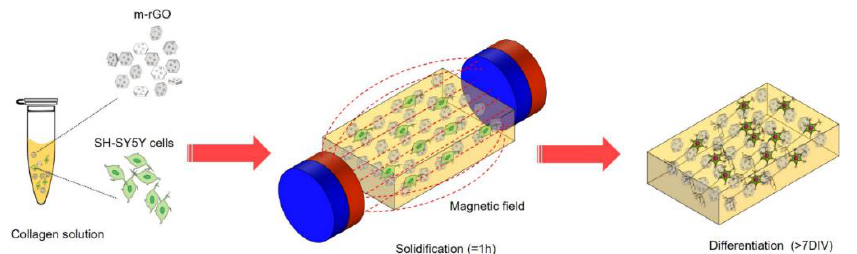
Figure 8. Magnetic-assisted cell alignment for a magnetic-responsive nanocomposite of rGO/collagen hydrogel